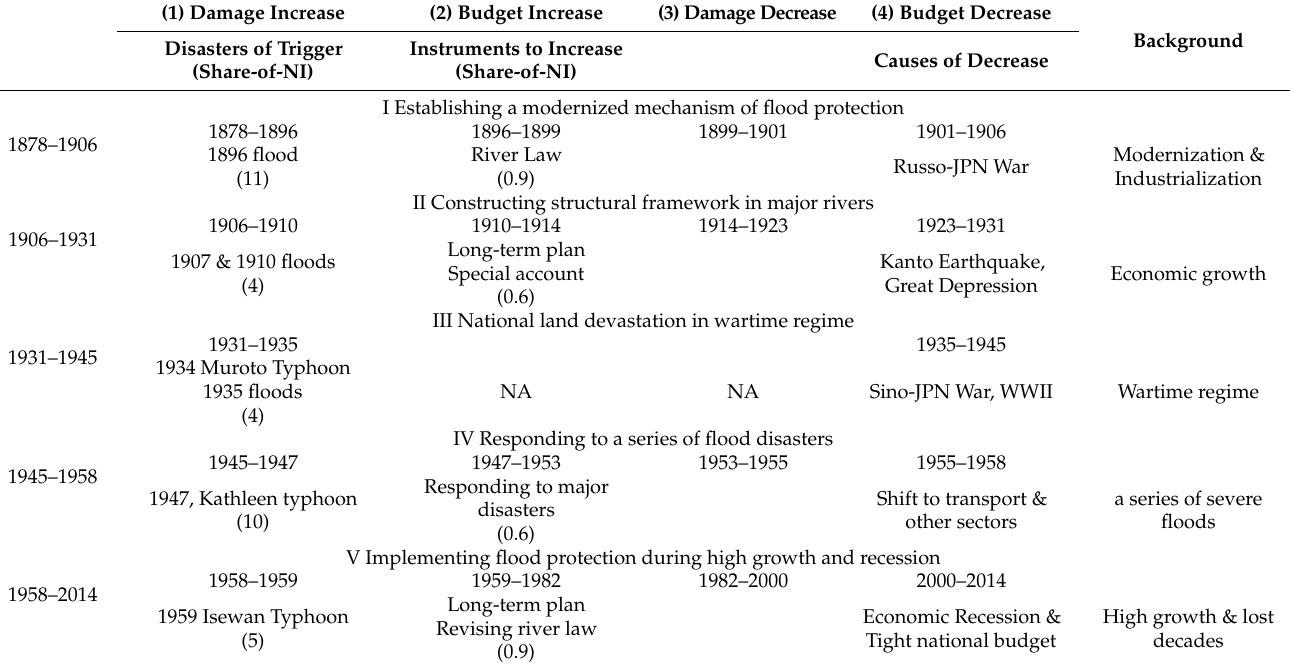
Table 1. Outline of investment